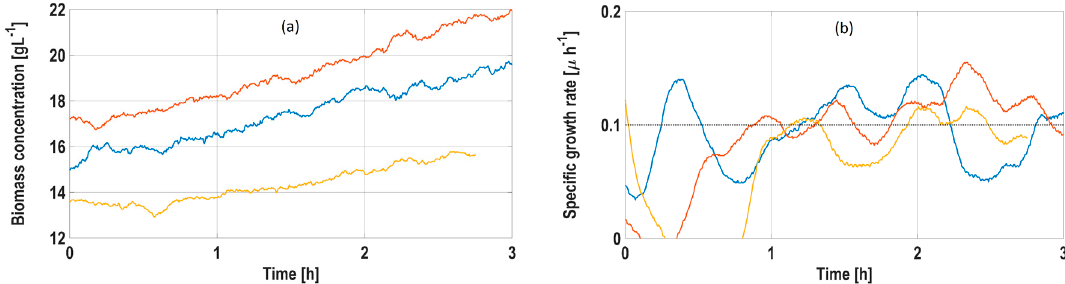
Figure 10. Biomass concentration profiles ( a ) and specific growth rate estimates ( b ) during three fed-batch phases run at µ sp = 0.1 h − 1